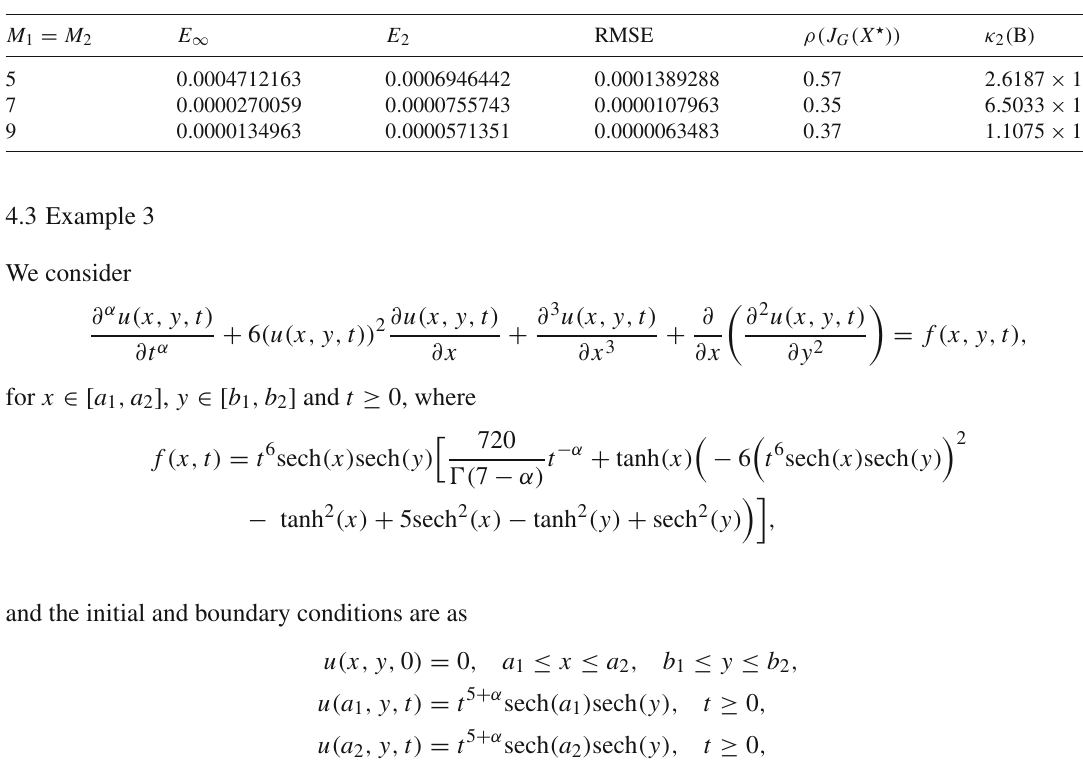
Table 9 The E ∞ , RMSE errors and C − Order for various values of τ obtained by M 1 = M 2 = 9 and MQ-RBFs with c = 1 . 95 for α = 0 . 2, [ a 1 , a 2 ] = [ b 1 , b 2 ] = [− 1 , 1 ] and t = 1 in Example 3 τ E ∞ E 2 RMSE C 0 . 2 0 . 0157580814 − 0 . 1